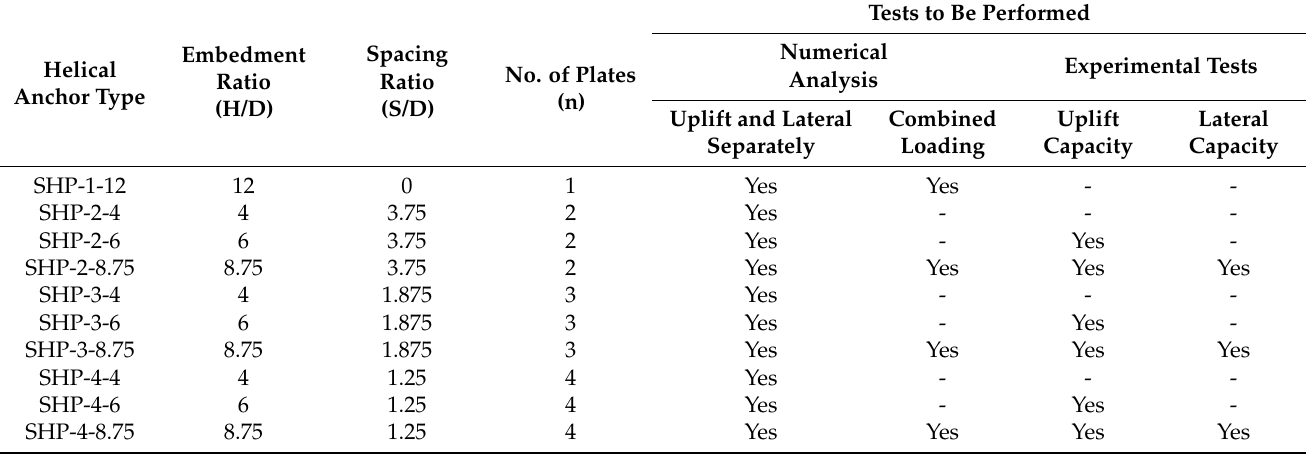
Table 1. Overview of testing program.